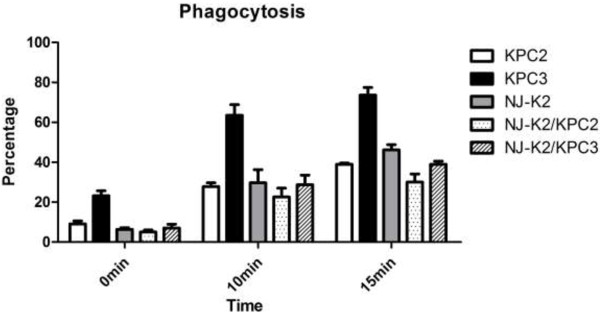
Neutrophils phagocytosis assays among Isolates of KPC-2 and -3, serotype K2 recipient and their transconjugants.